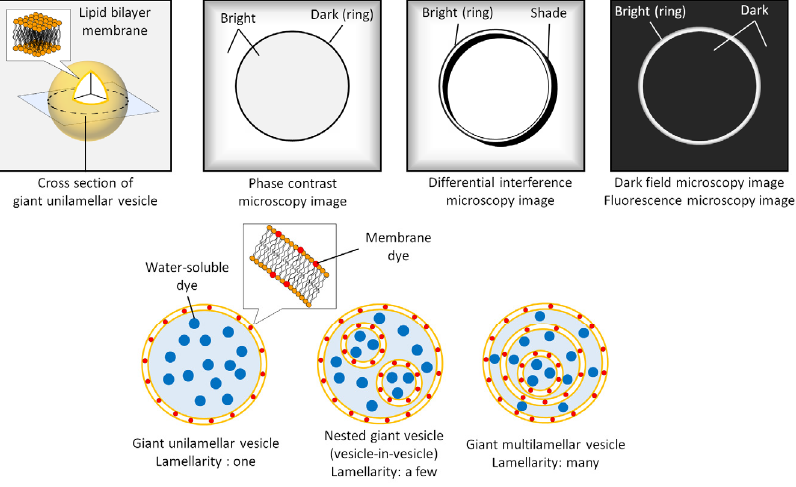
Figure 1. Schematic illustration of giant vesicles and their cross-sectional images in different kinds of microscopic technologies.